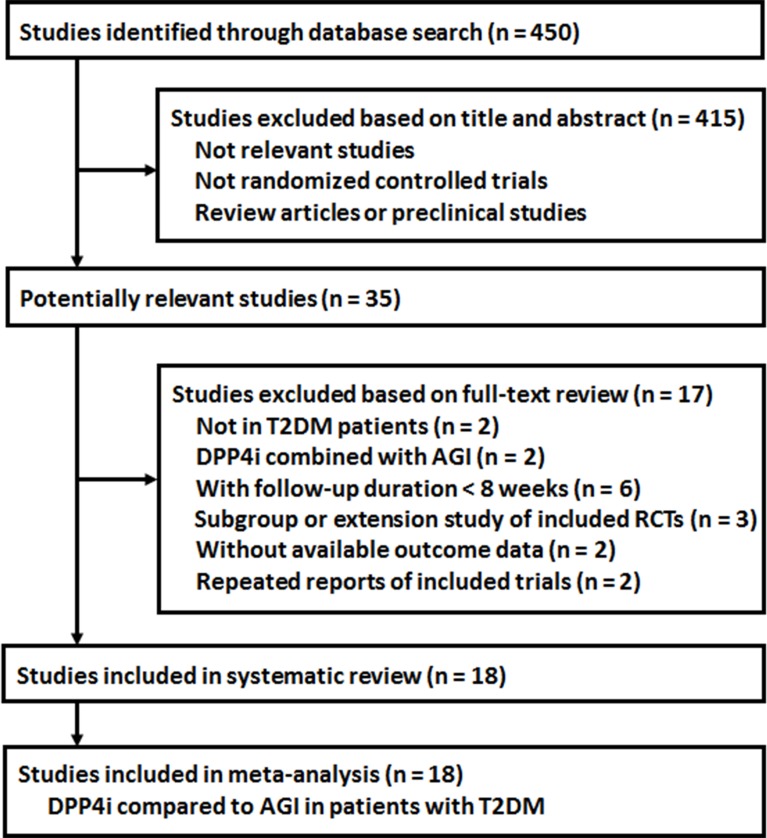
Flowchart of database search and study identification of the meta-analysis.